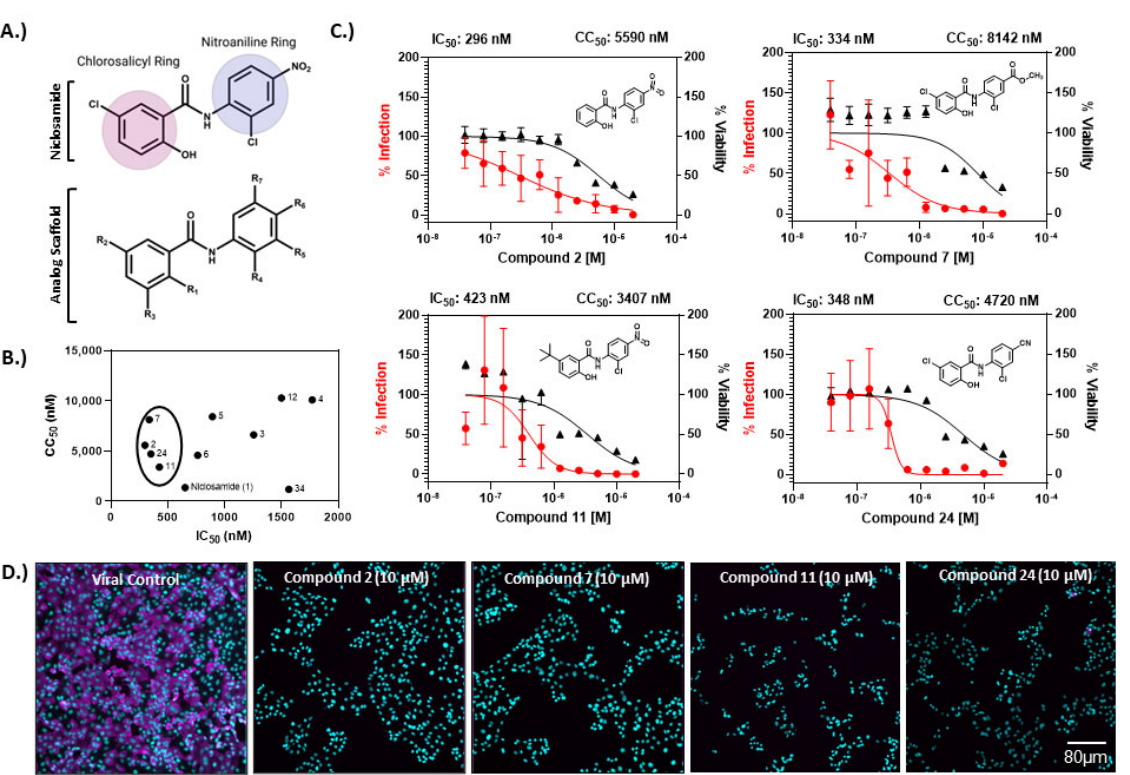
Figure 4. Niclosamide analogs have improved efficacy and reduced cytotoxicity in VeroE6. ( A ) Struc- ture of niclosamide indicating the chlorosalicyl/nitroaniline rings, and analog scaffold with modified substituent positions labeled. ( B ) IC 50 vs. CC 50 plot highlighting efficacious compounds in VeroE6. Compounds with improved potency and cytotoxicity profiles are circled on the plot. ( C ) 10-point, 2-fold concentration–response curves for the top four niclosamide analogs with a starting concen- tration of 20 µ M. Data are shown as the mean ± SEM of n = 3 replicate wells per condition. Curves for infection (in red) and cell viability (in black) are included. ( D ) Representative images of infected cells treated with indicated compounds and viral control (Vehicle). (10 × magnification, cyan = nuclei, magenta = SARS-CoV-2 nucleocapsid protein, scale bar = 80 µ m).